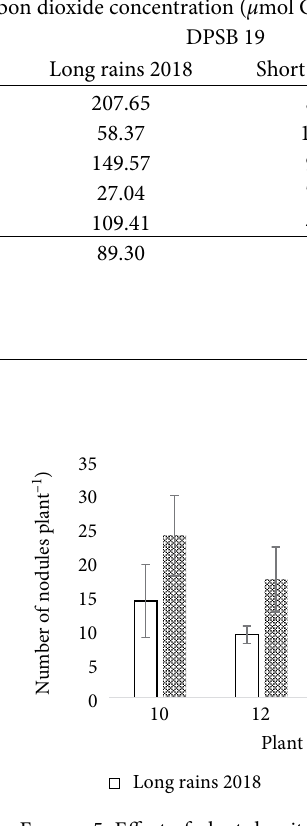
Figure 5: Effect of plant density and season on nodulation at 50% flowering stage. Vertical bars represent ± standard error. Values significantly different at 푝 < 0.05